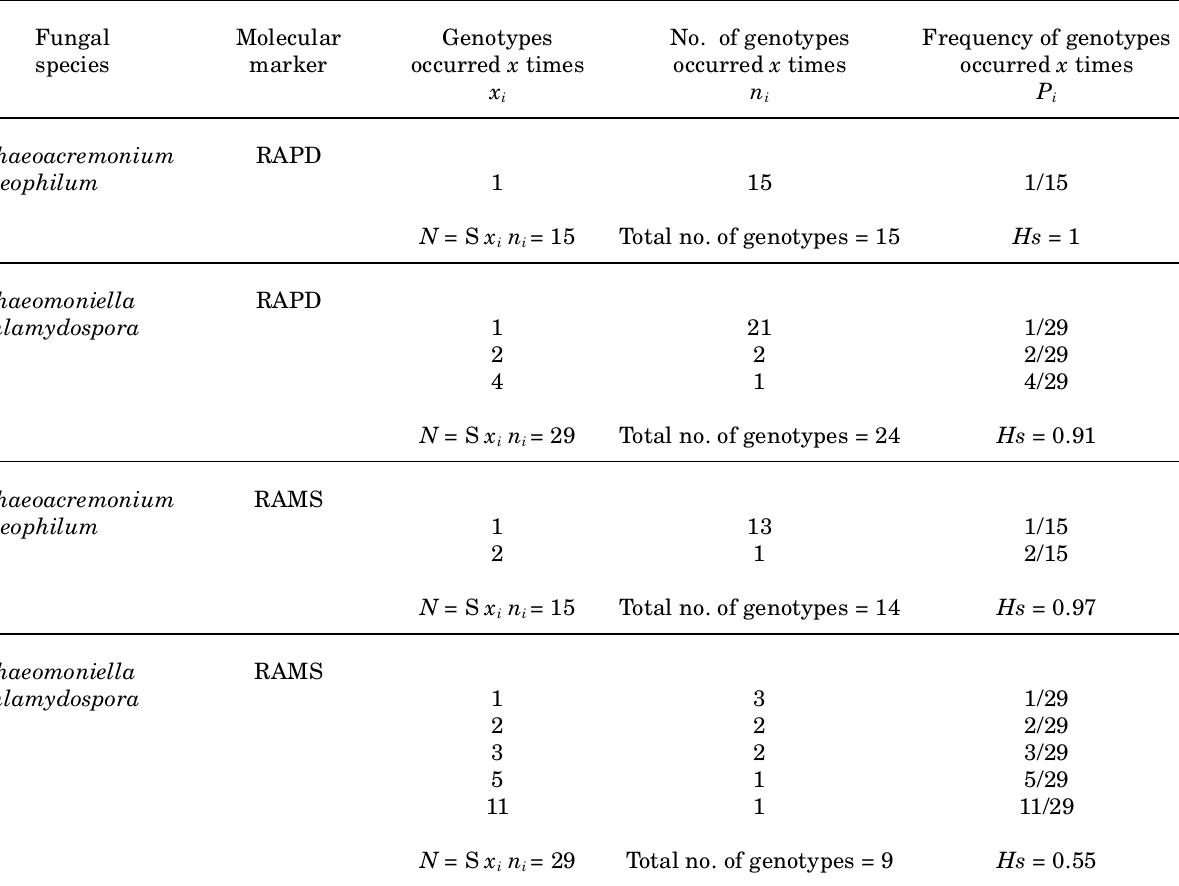
Table 2. Number ( n ) and frequency ( P ) of multilocus genotypes occurring ( x ) times and detected in Phaeoacremo- nium aleophilum and Phaeomoniella chlamydospora with RAPD and RAMS experiments. For each species and primers, the genotypic diversity ( Hs ) is shown. N = sample